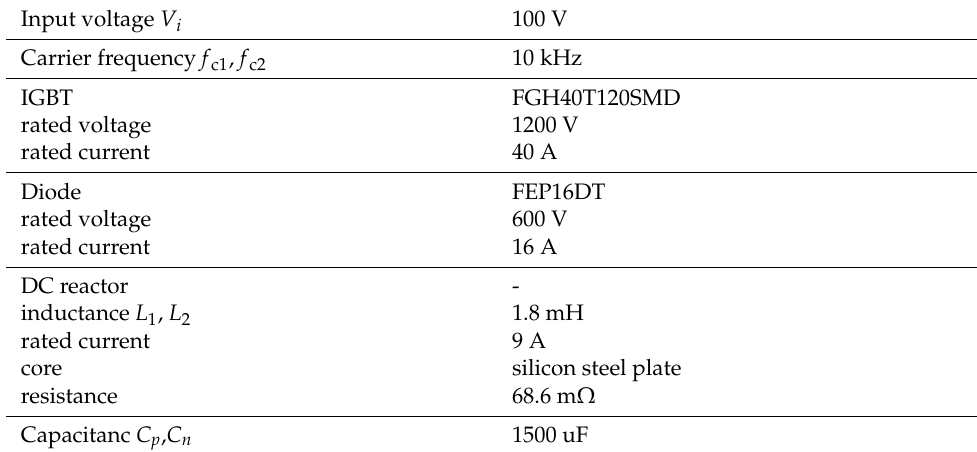
Table 1. Circuit conditions.